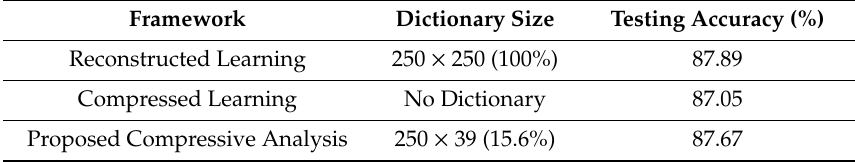
Table 3. Dictionary size and accuracy of the di ff erent algorithms *.